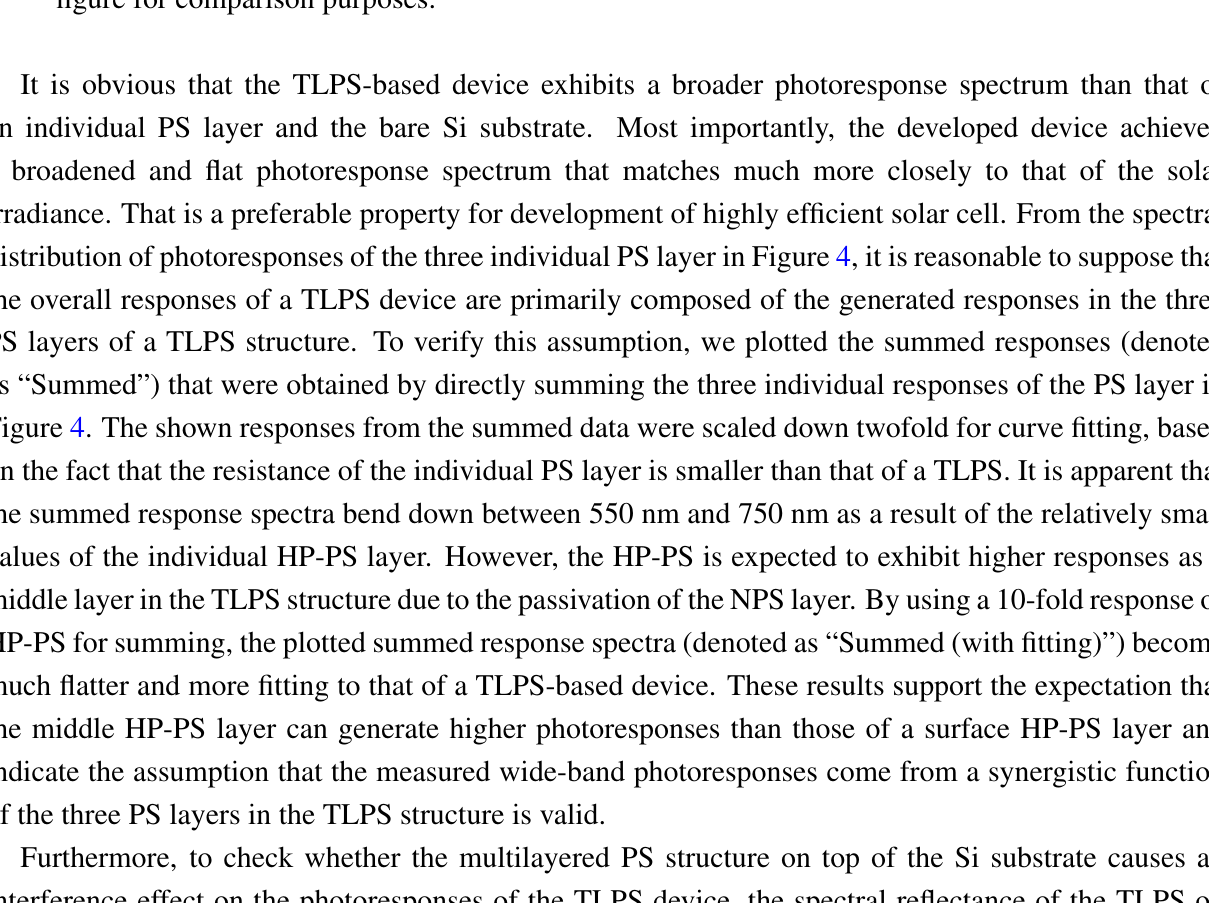
Figure 5. The spectral photoresponses of the developed photovoltaic devices based on the TLPS structure and the individual PS (NPS, HP-PS or LP-PS) layer. The summed data (blue dotted line) were obtained by directly summing the three individual responses of the PS layer in Figure 4, while the summed (with fitting) data (red dotted line) were obtained by using a 10-fold responses of HP-PS. The spectrum of solar irradiation is also shown in the figure for comparison purposes.